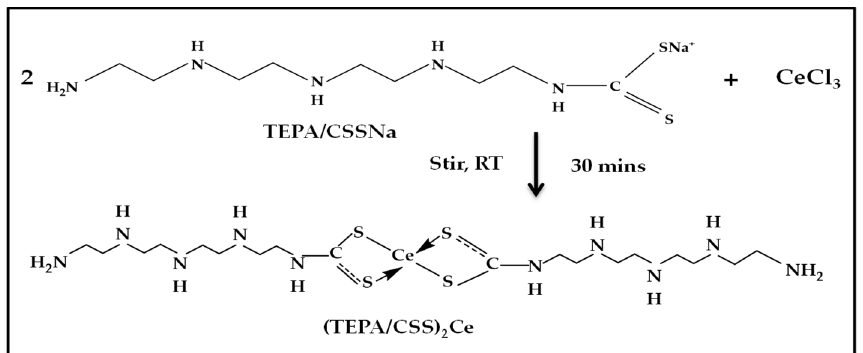
Figure 4. The synthesis and molecular structure of (TEPA/CSS) 2 Ce.